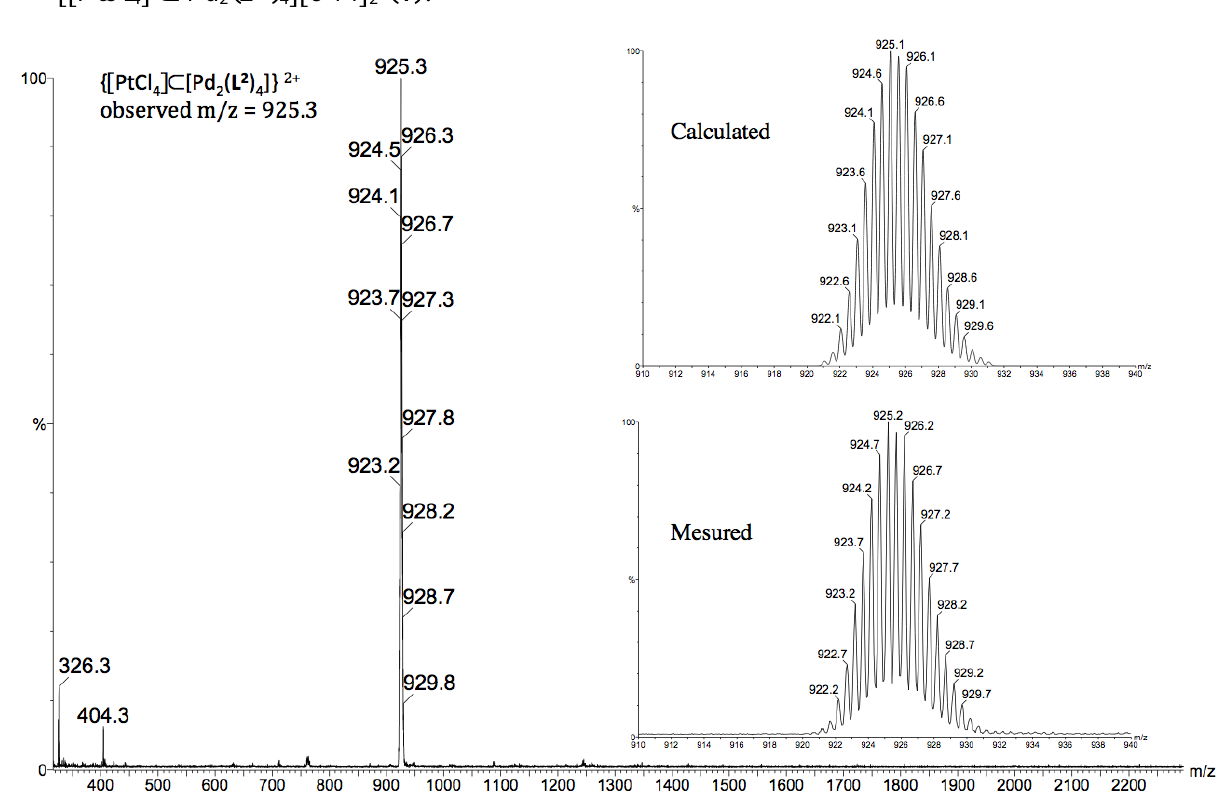
Figure 6. Calculated and observed isotope pattern for the intact